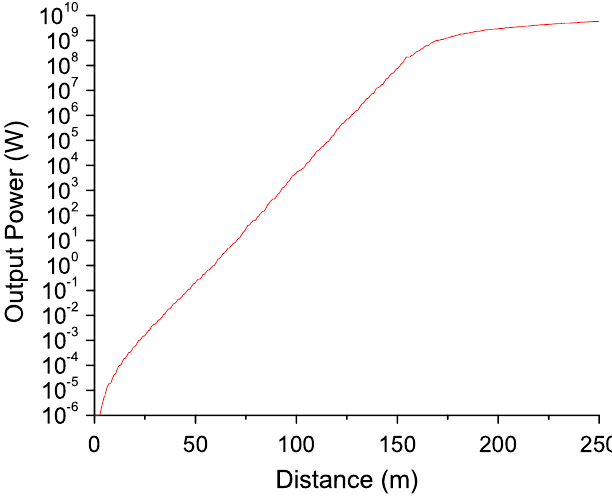
FIG. 9. (Color) GENESIS simulation of the 20 pC, 2 fs rms pulse length beam at LCLS, full LCLS energy (14.3 GeV). Violation of the Pellegrini criterion causes dramatic growth in the gain length.